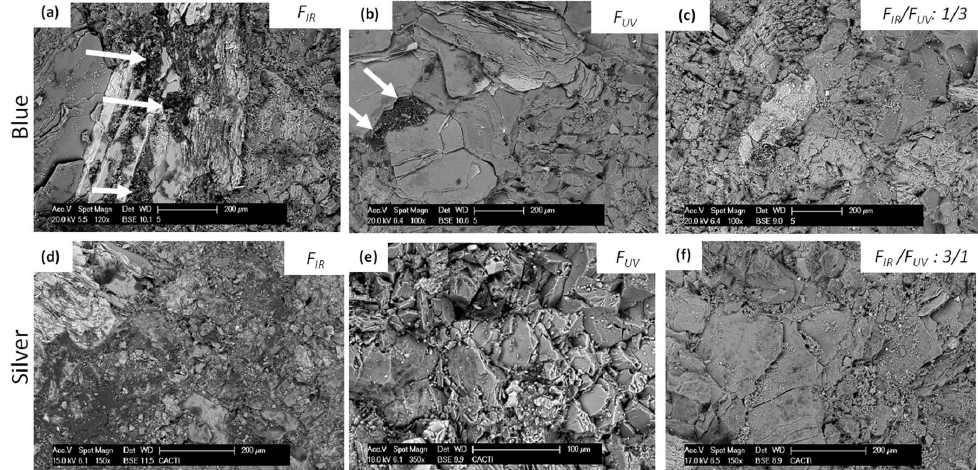
Figure 6. SEM micrographs of the areas treated with the selected conditions to extract blue ( a – c ) and silver ( d – f ) graffiti paints using 1064 nm (IR) ( a , d ); 355 nm (UV) ( b , e ) and their simultaneous use ( c , f ). Graffiti remains are pointed out with arrows. Detailed information on fluence values and pulses for each irradiation condition can be found in Table 2.